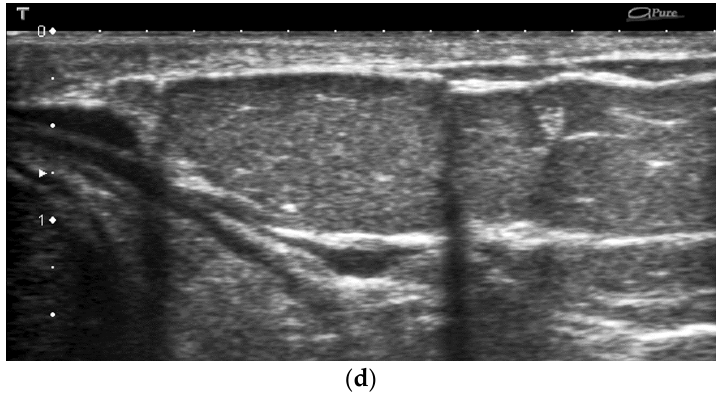
Figure 12. Rolled nipple technique. The nipple is rolled towards the finger of the contralateral hand with the probe. Photograph of the manoeuver ( a ) and its corresponding drawing ( b ). US pre manoeuver ( c ) and post manoeuver ( d ) images.